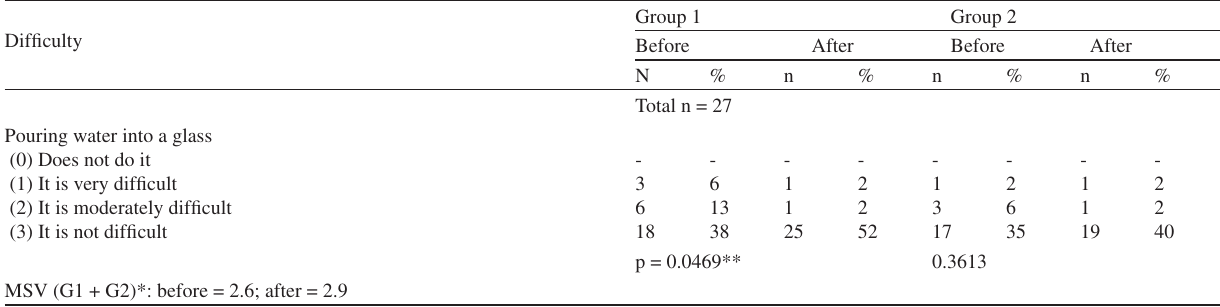
Table 5 - Subjects’ perception of difficulties with activities related to depth perception before and after capsulotomy. Difficulty